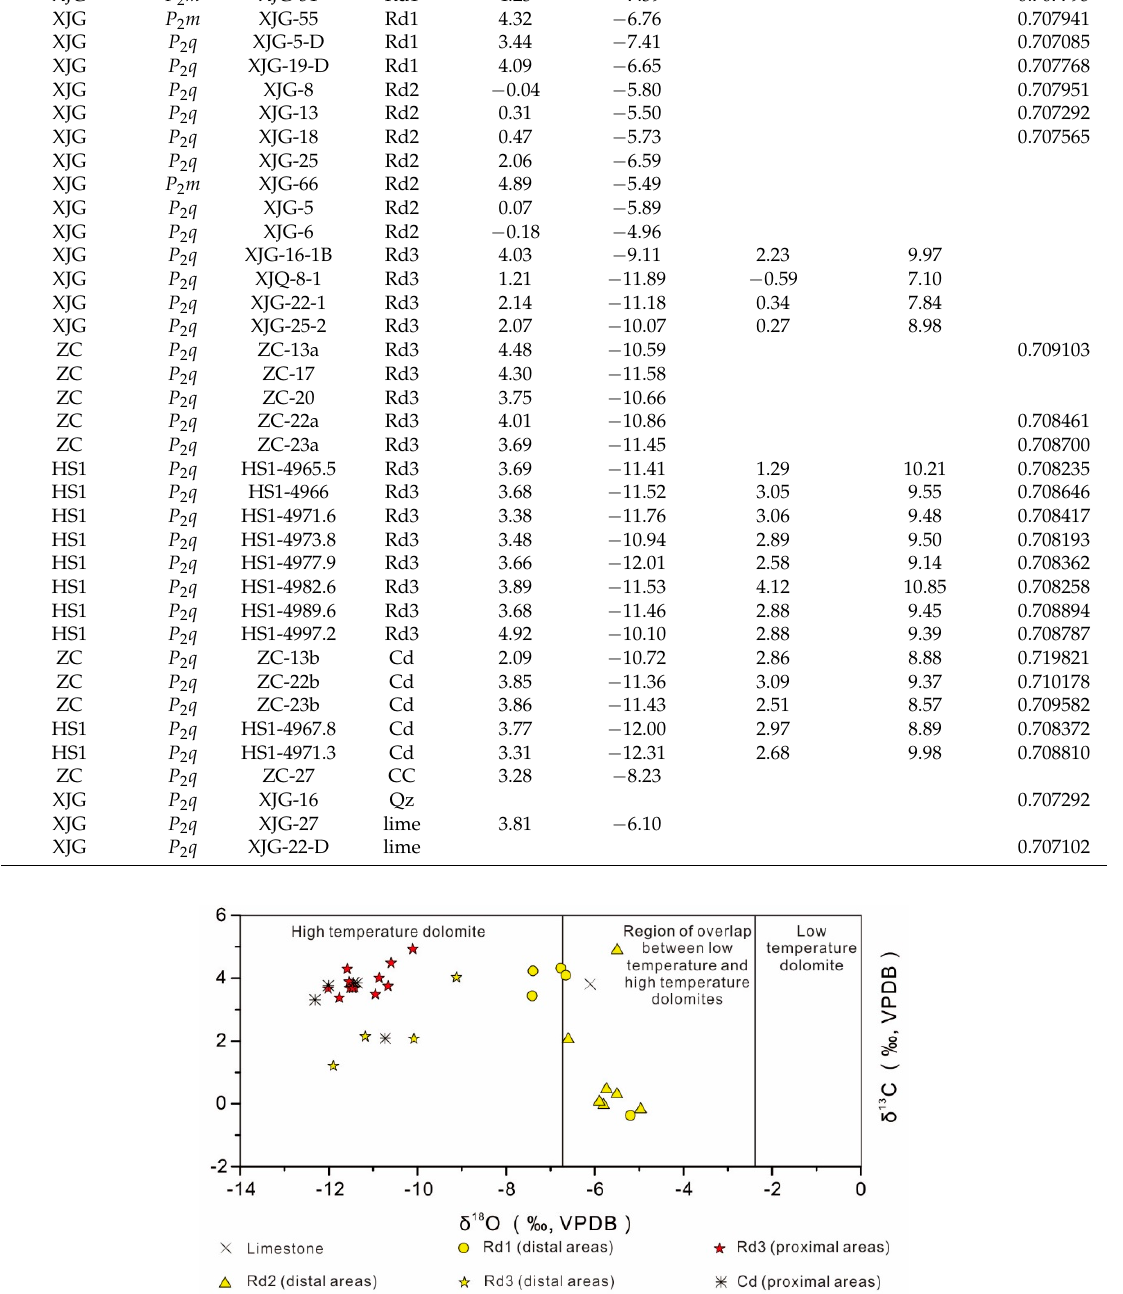
Figure 12. Cross-plot of δ 13 C and δ 18 O values for limestone, replacive dolomites (Rd1–Rd3), and cement dolomite (Cd). Typical ranges of isotopic values for dolomite formed in low temperatures and high temperatures [46].